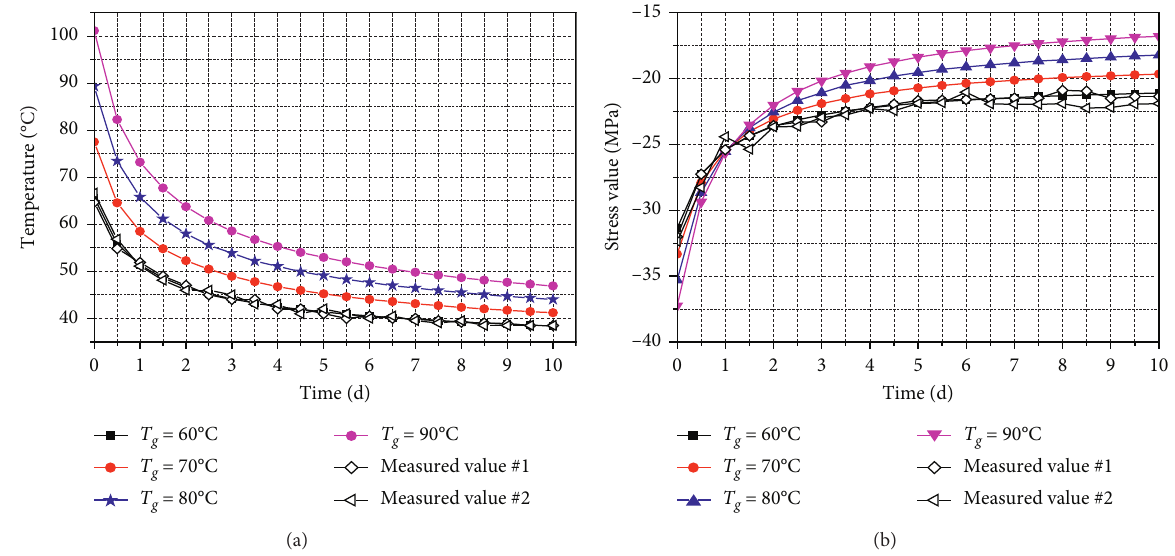
Figure 8: Comparison of the theoretical solution and field measured data: (a) temperature and (b) stress.